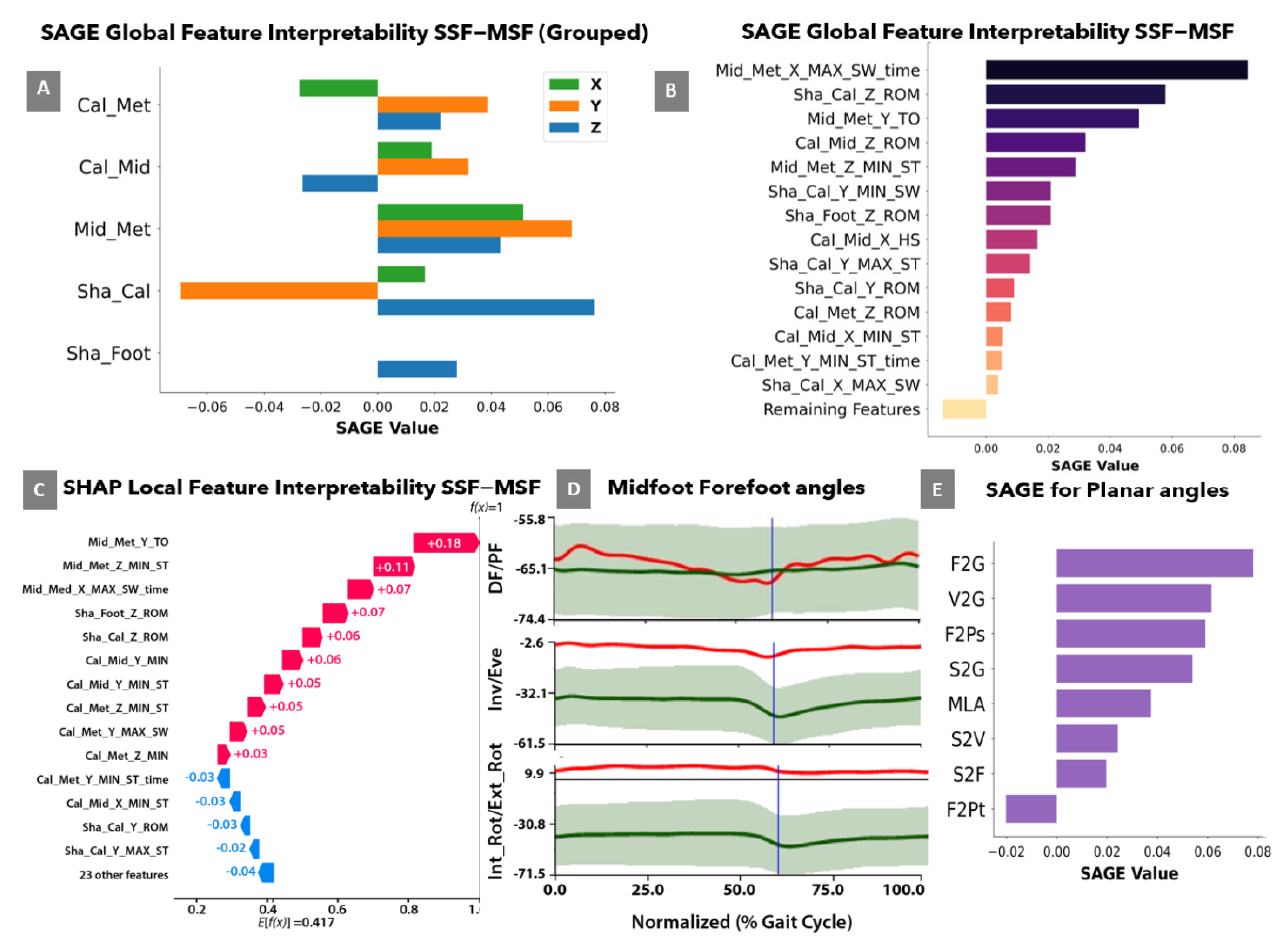
Figure 3. ( A ) SAGE values for feature groups for dorsiflexion/plantarflexion, inversion/eversion, and internal/external rotation angles corresponding to the X, Y and Z components, respectively of MSF and SSF features, ( B ) SAGE values for individual feature ranking showing the 15 top most ranked features ( C ), SHAP waterfall plot for local interpretation of a sample autism case (A14), red arrow shows prediction contribution towards the autism category and blue arrows shows prediction contribution towards the control category ( D ) Mid-Met angle values in the three planes for A14 (shown by red line vs. control mean +/ − 1SD shown by green), and ( E ) SAGE values for planar feature